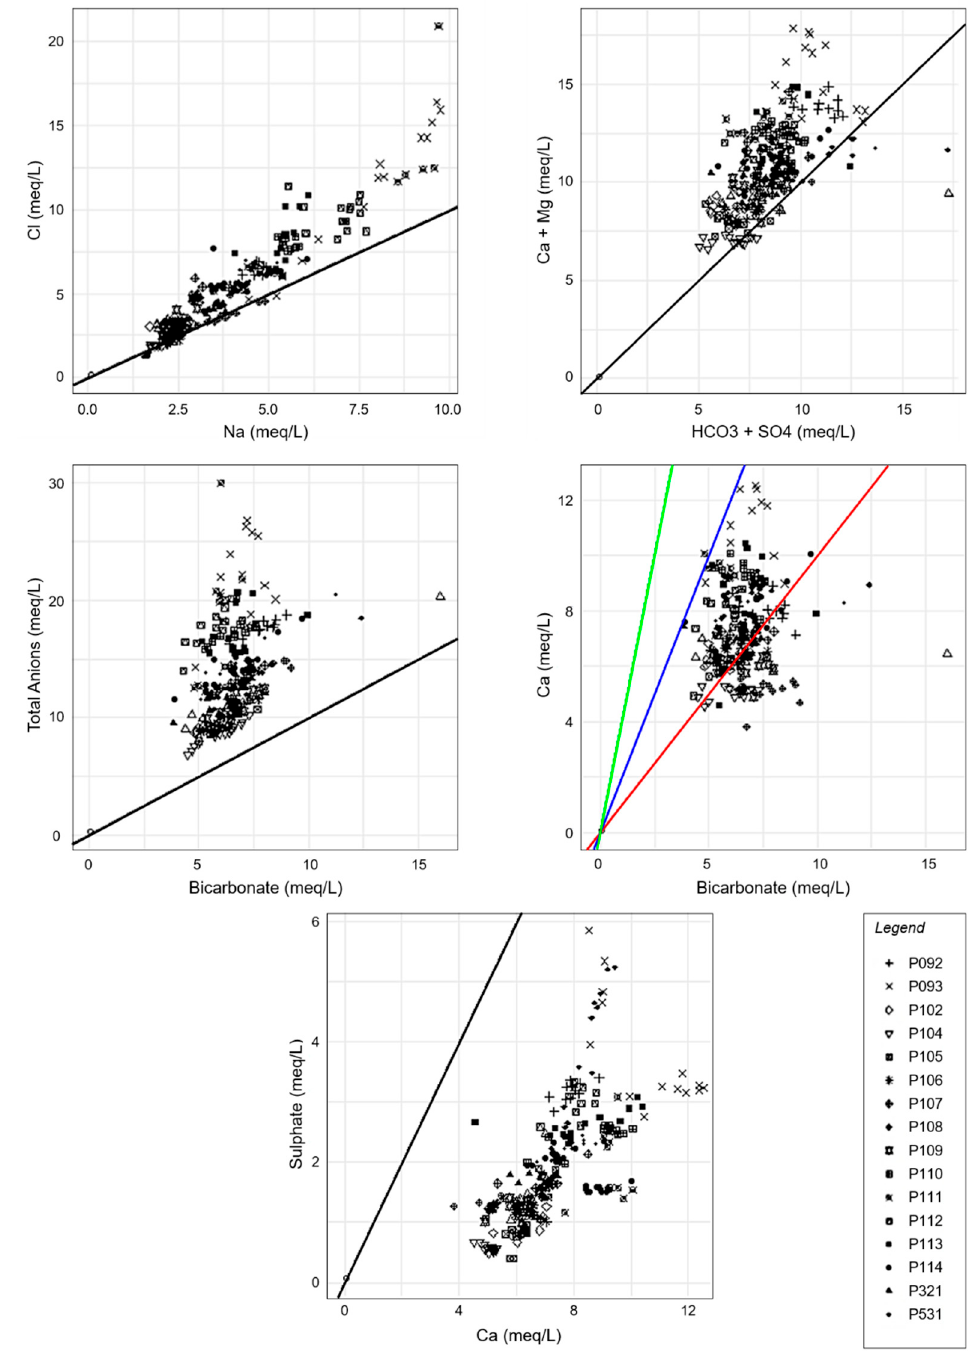
Figure 5. Ionic relationships useful for aquifer matrix characterizations.